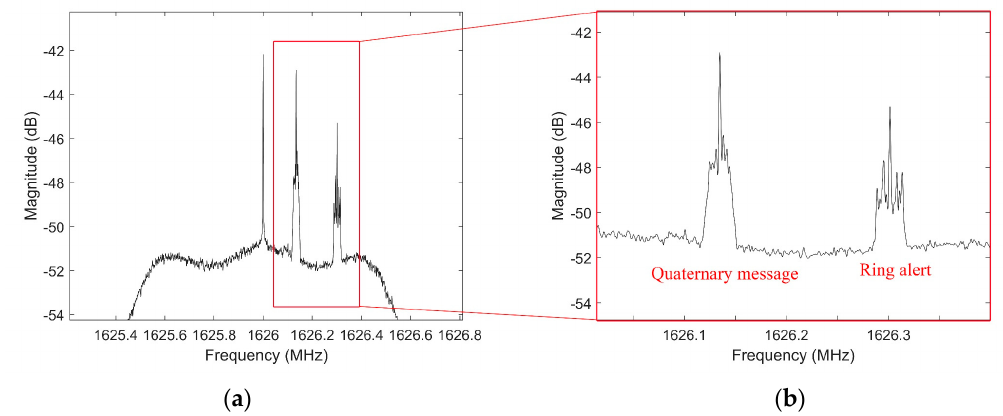
Figure 9. ( a ) PSD of Quaternary message burst of Iridium-Next and ( b ) PSD of Ring alert burst of Iridium-Next.